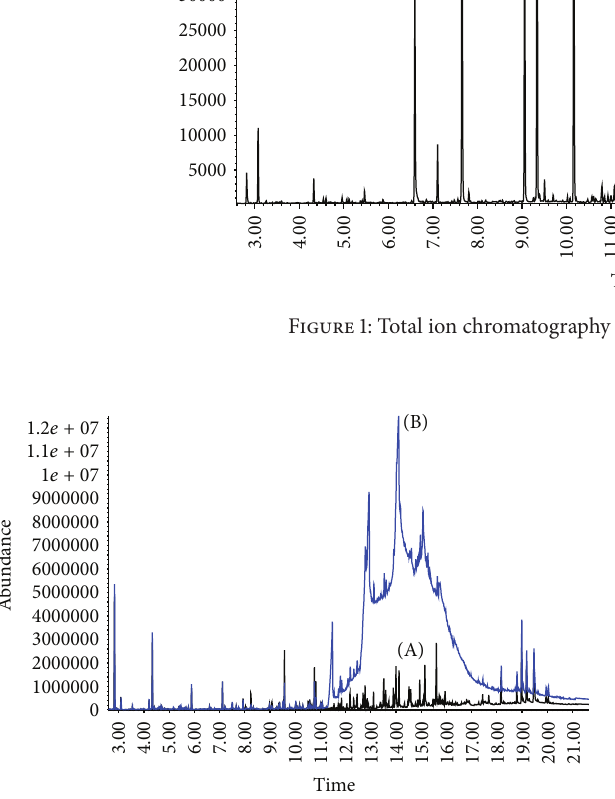
Figure2:MatrixinterferenceisreducedinoystersduringSBSEwith use of 0.1 M NaHCO 3 (A) instead of water